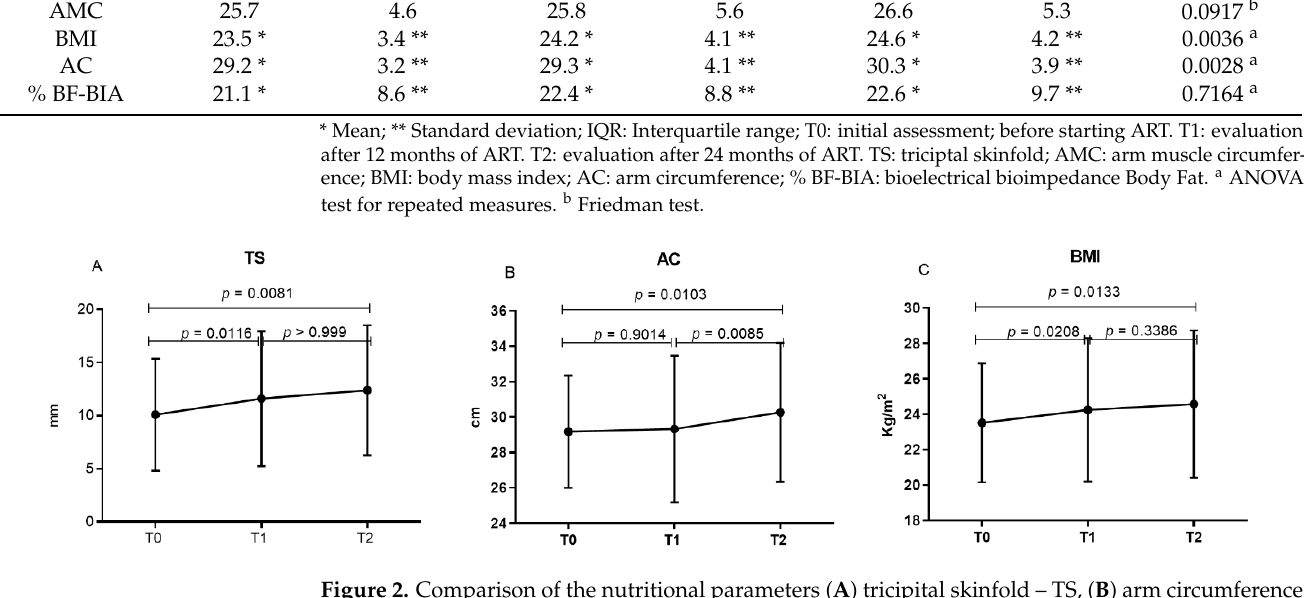
Table 5. Distribution of PLHIV according to the antiretroviral therapy regimen used.